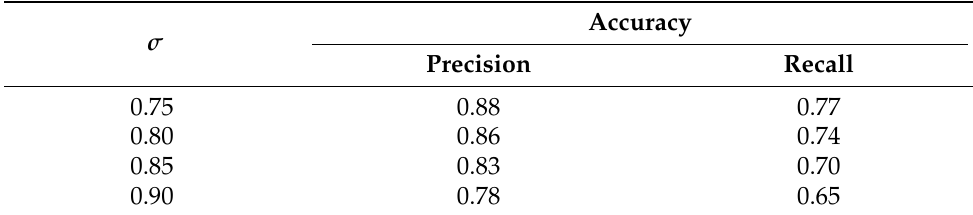
Table 3. Identification results of the trailing